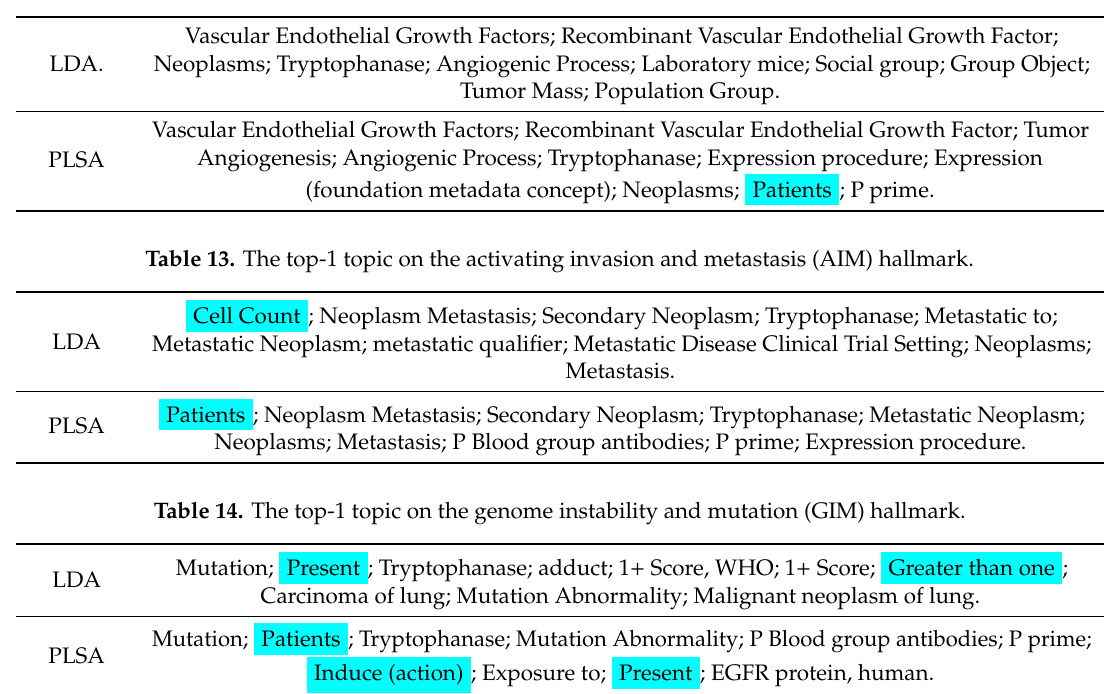
Table 12. The top-1 topic on the inducing angiogenesis (IA) hallmark.